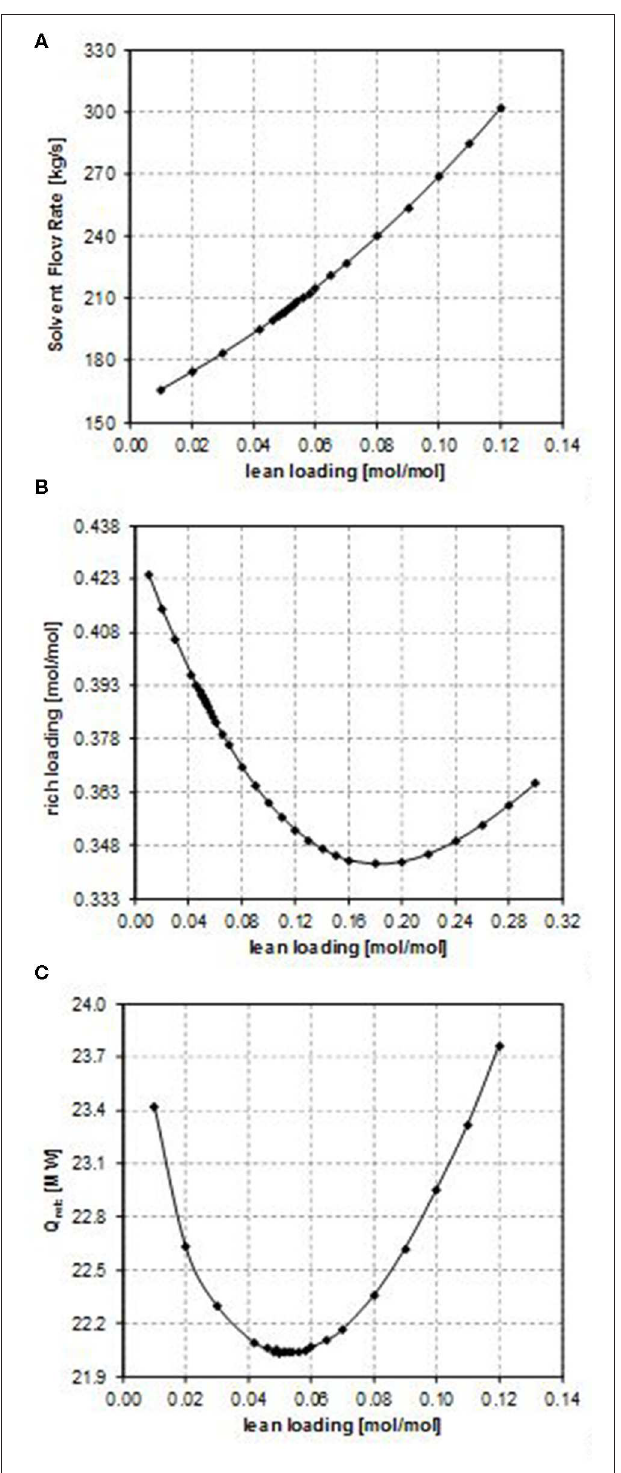
FIGURE 3 | Effect of the CO 2 lean loading on (A) the solvent flow rate, (B) the rich loading, and (C) the reboiler duty ( case E ).